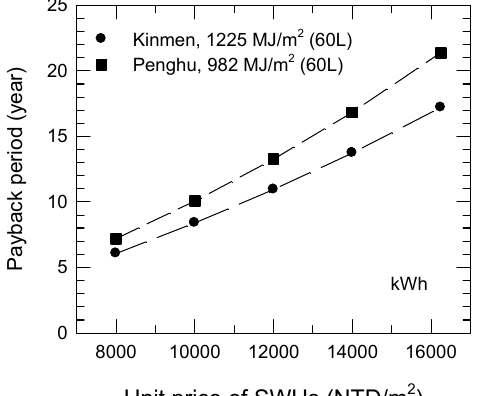
Figure 6. Payback period as a function of unit price of